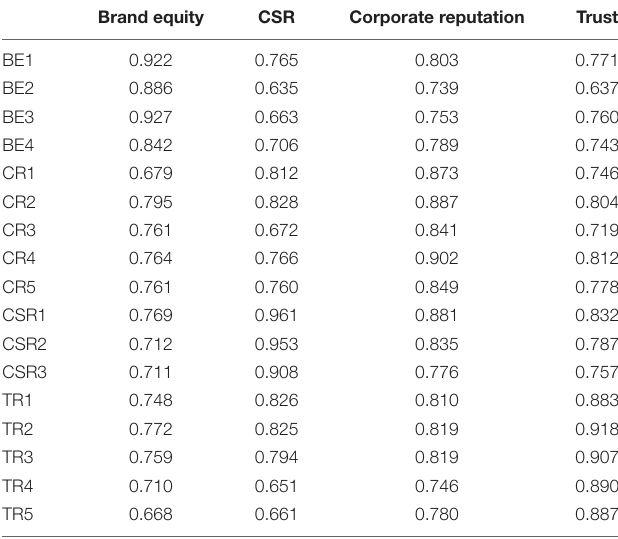
TABLE 6 | R square—R 2 .